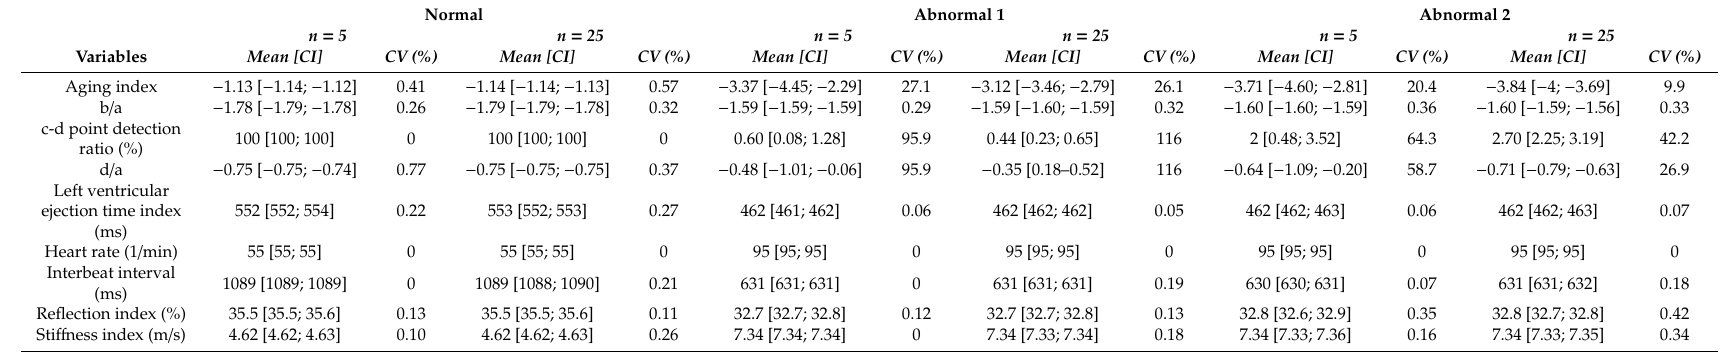
Table 1. Results of repeatability measurements. Means (and confidence intervals (CIs)) and coe ffi cients of variation (CVs) of pulse contour variables measured by the SCN4ALL telemedicine system. In order to evaluate the repeatability of the measurements by the system, we detected and analyzed artificial pulse signals generated by a pulse oximeter simulator device. Three di ff erent signal settings of the simulator were selected (Normal, Abnormal 1, and Abnormal 2). For each setting, measurements were repeated 5 times with a single randomly chosen pulse oximeter (n = 5 columns), and then these measurements were supplemented with the repeated measurements from 4 other pulse oximeters of the same release (n = 25 columns, showing the results of 5 × 5 measurements). Normal Abnormal